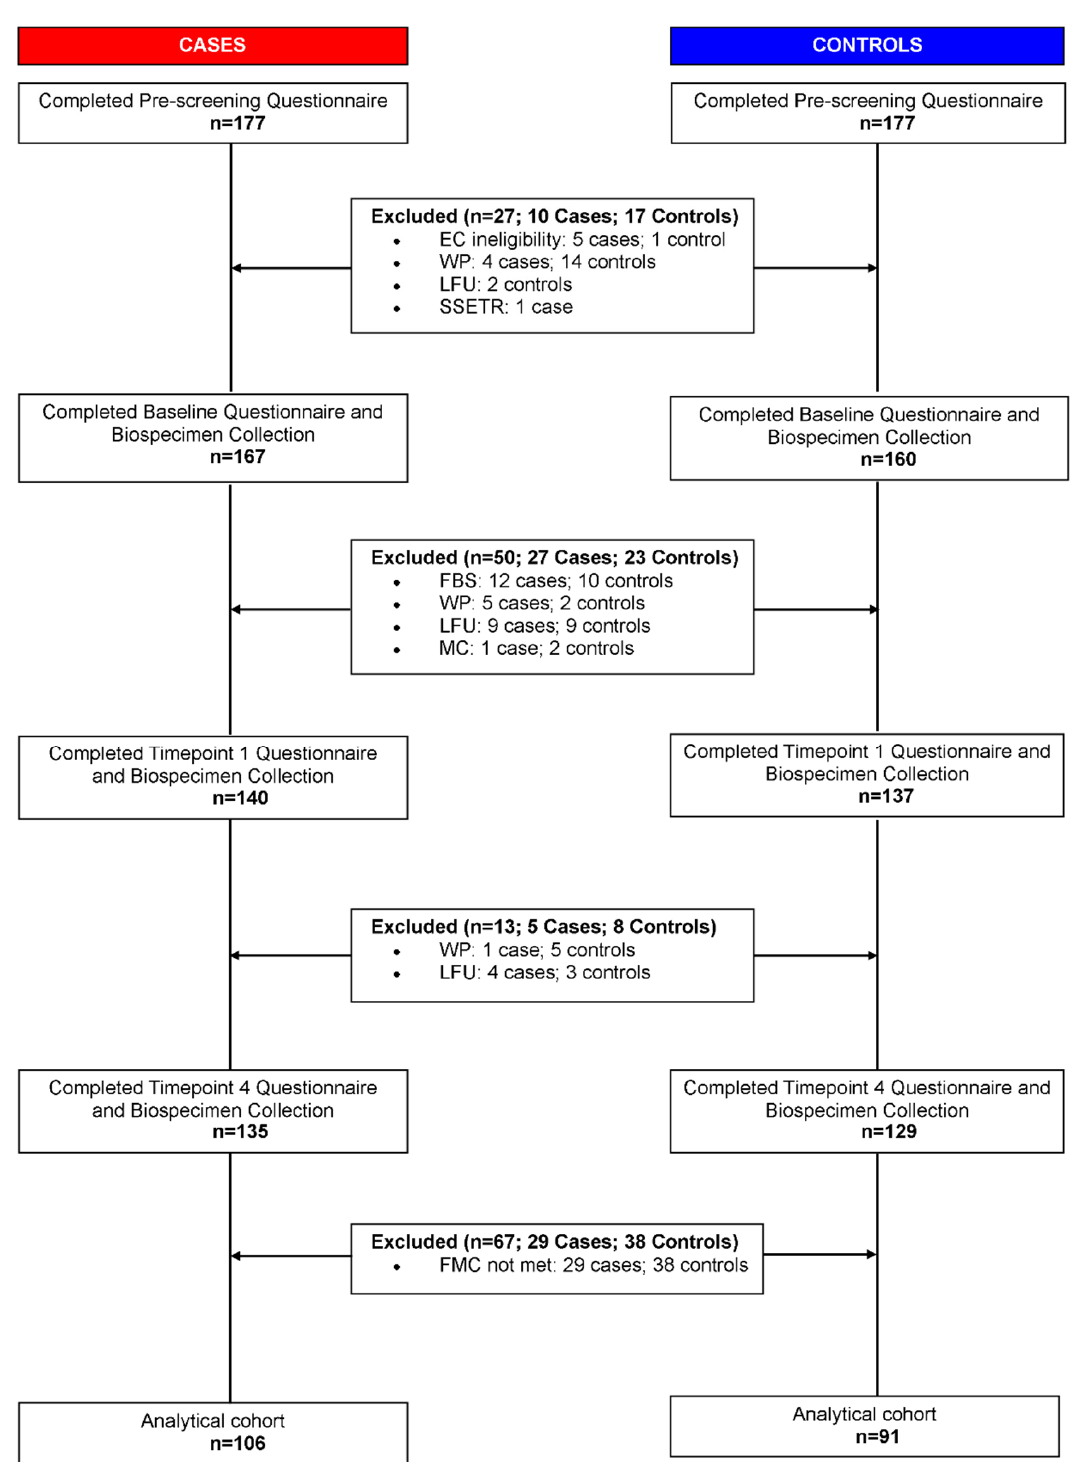
Figure 1. Pipeline for sample selection. EC: Exclusion criteria; WP: Withdrew participation; LFU: Loss to follow up; SSETR: Study site enrollment target reached; FBS: Failed baseline screening; MC: Medical conditions; FMC: Frequency matching criteria.